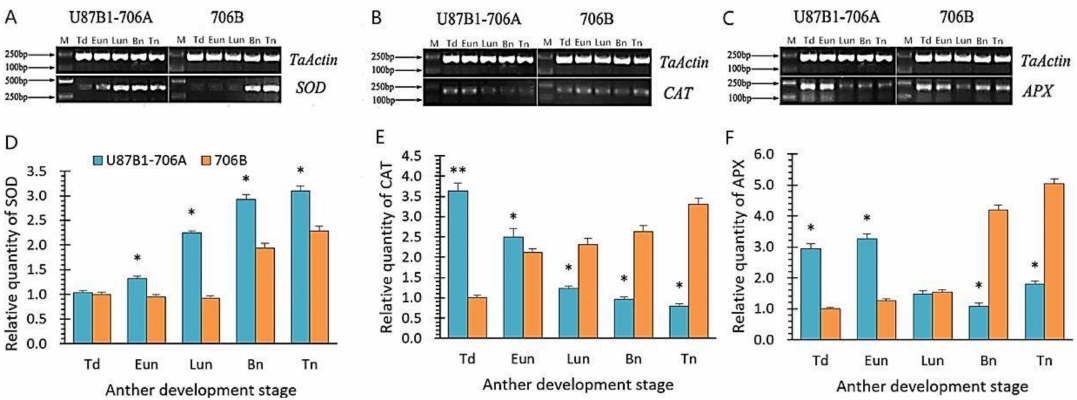
Figure 9. Results of gene expression for SOD ( A , D ), CAT ( B , E ), and APX ( C , F ) in anthers from U87B1-706A and 706B during different developmental stages. Td, tetrad stage; Eun, early uninucleate stage; Lun, late uninucleate stage; Bn, binucleate stage; and Tn, trinucleate stage. M, Marker D2000. Students’ t test * p < 0.05, ** p < 0.01. Each value represents the mean ± SD ( n =